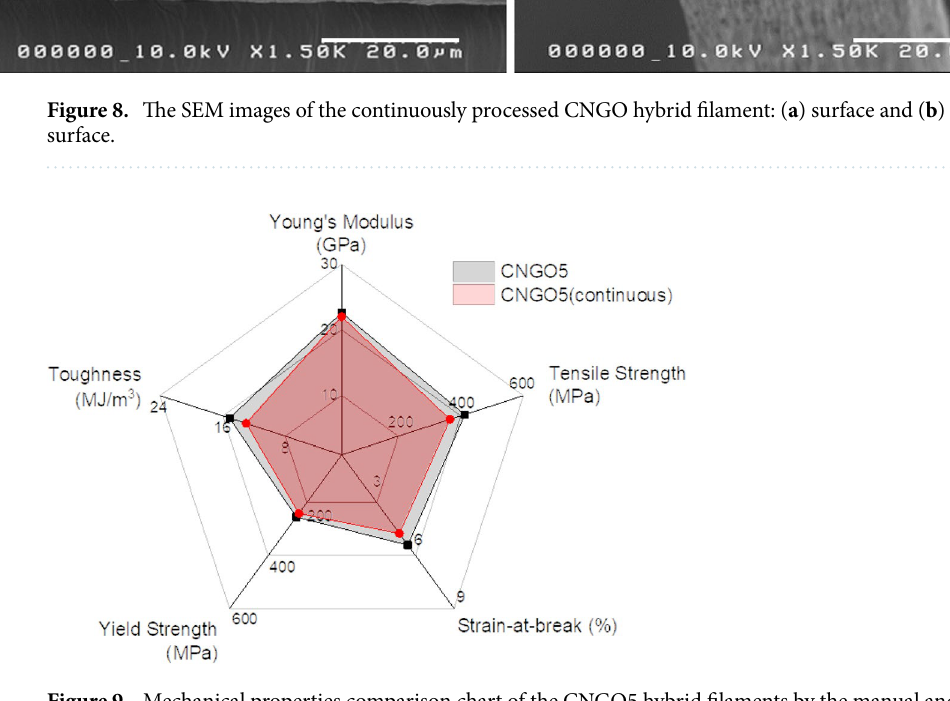
Figure 9. Mechanical properties comparison chart of the CNGO5 hybrid filaments by the manual and continuous